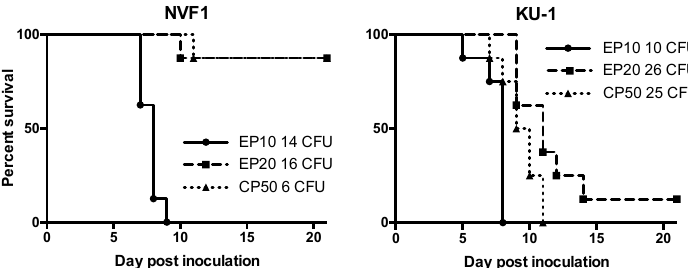
Figure 7. Attenuation of passaged variants of Francisella tularensis . Survival rate of mice inoculated with the passaged variants of NVF1 and KU-1. The variants passaged on Eugon chocolate agar 10 times (EP10) and 20 times (EP20), and the variants passaged on Chamberlain’s chemically defined medium-based agar 50 times (CP50) of NVF1 and KU-1 were inoculated intradermally into 6-week-old male C57BL/6J mice ( n = 8 per group) with indicated colony-forming unit (CFU). The NVF1 EP20 and CP50 variants were significantly attenuated ( p < 0.001) compared with the NVF1 EP10 variants. Similar results were obtained with the variants of KU-1 EP20 and CP50 ( p < 0.001 and p = 0.008, respectively). p -Values less than 0.01 were considered statistically significant.